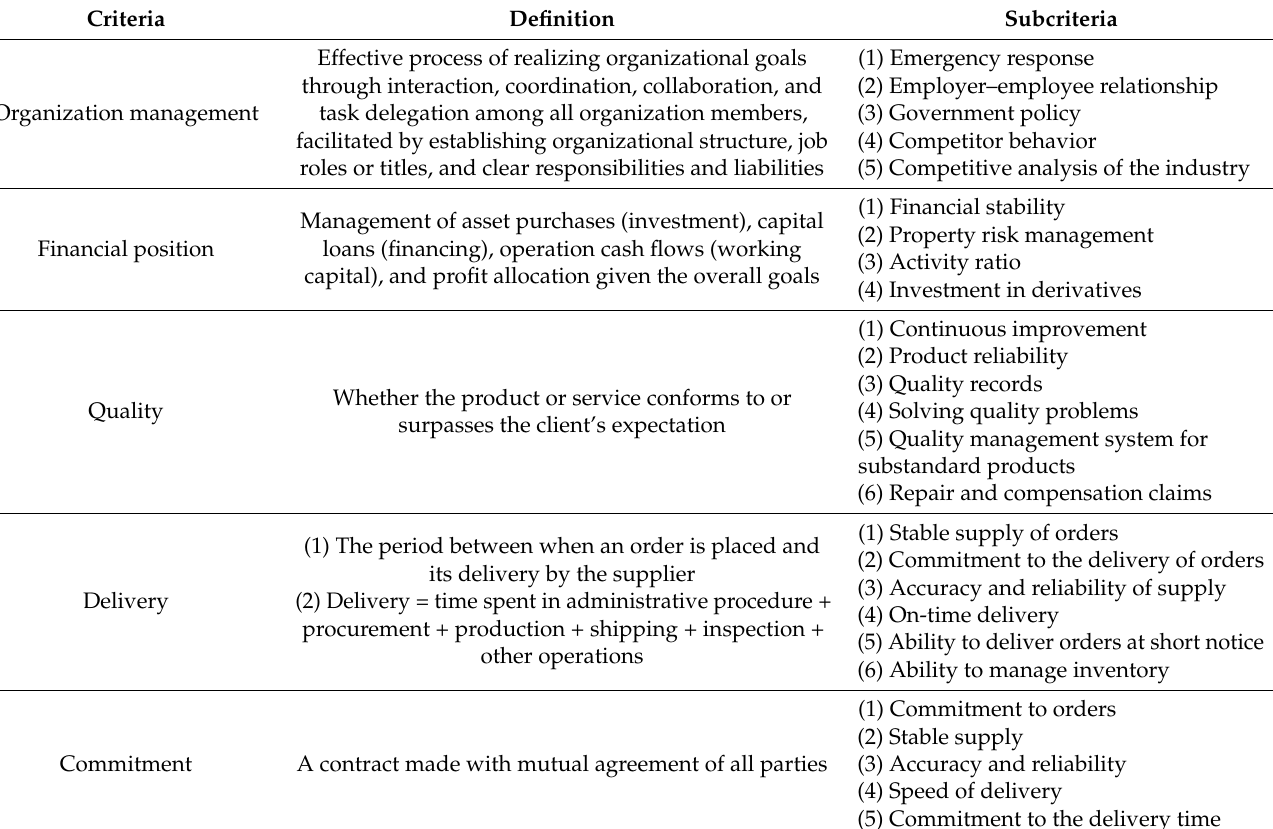
Table 1. Criteria and subcriteria determined by six key members of